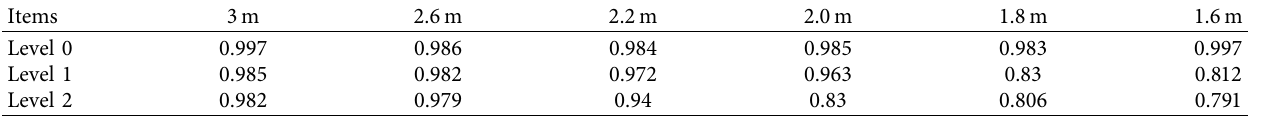
Table 14: Test results of actual arch bridge